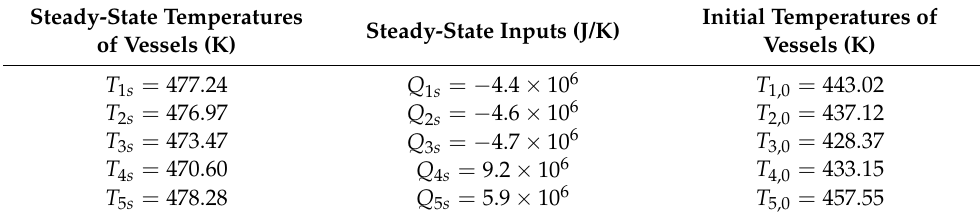
Table 2. The steady-state and initial